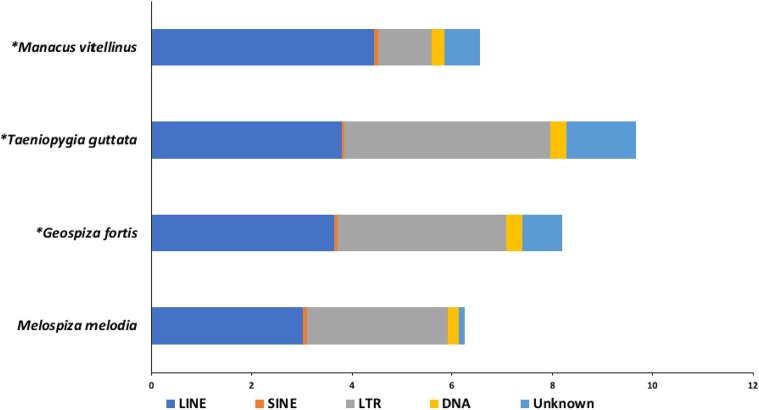
Comparison of percentages of transposable elements (TEs) among related songbird genome assemblies. * Data from: Zhang et al. (2014) Science. 346: 1311-1320.